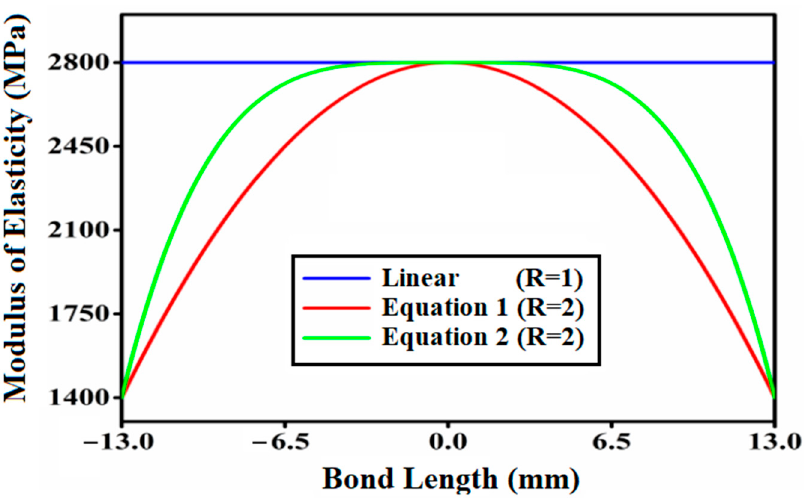
Figure 3. Parabolic fluctuation of modulus of elasticity (E) of the adhesive layer with modulus ratio R = 2 (Equations (1) and (2)). R = 2 (Equations (1) and